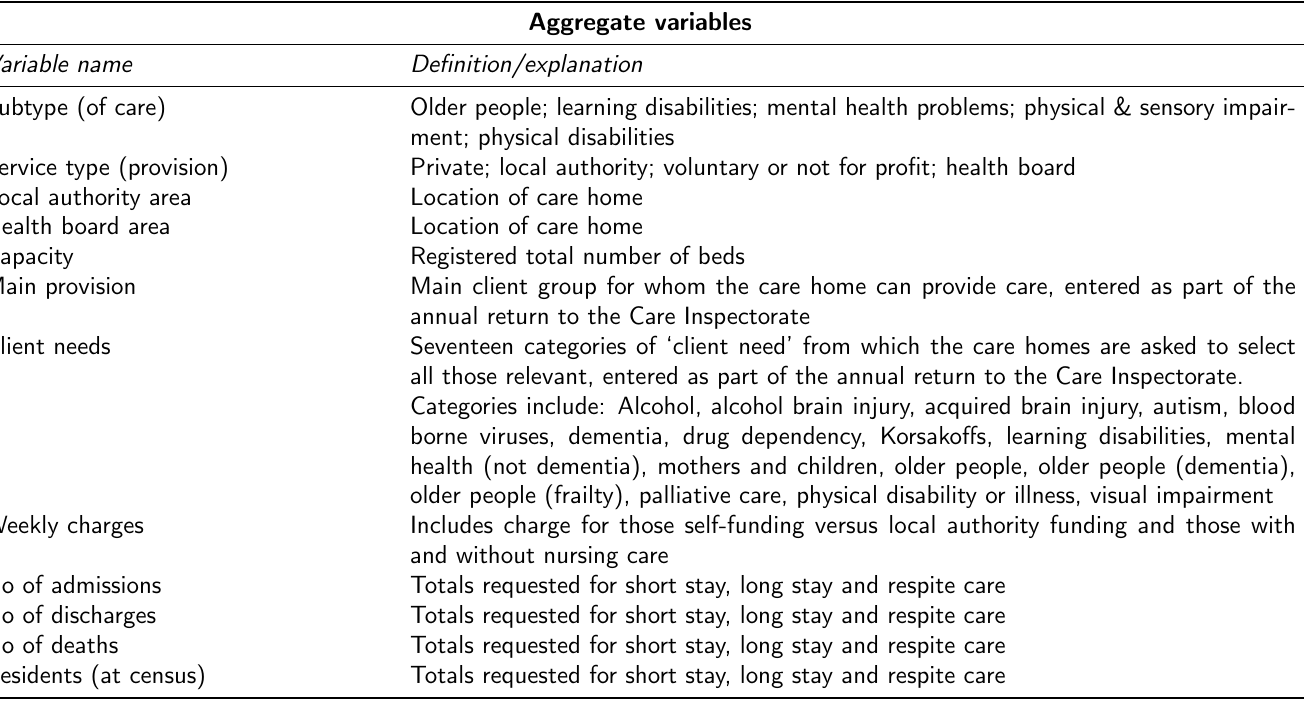
Table 3: Summary of aggregate and individual variables available from the SCHC